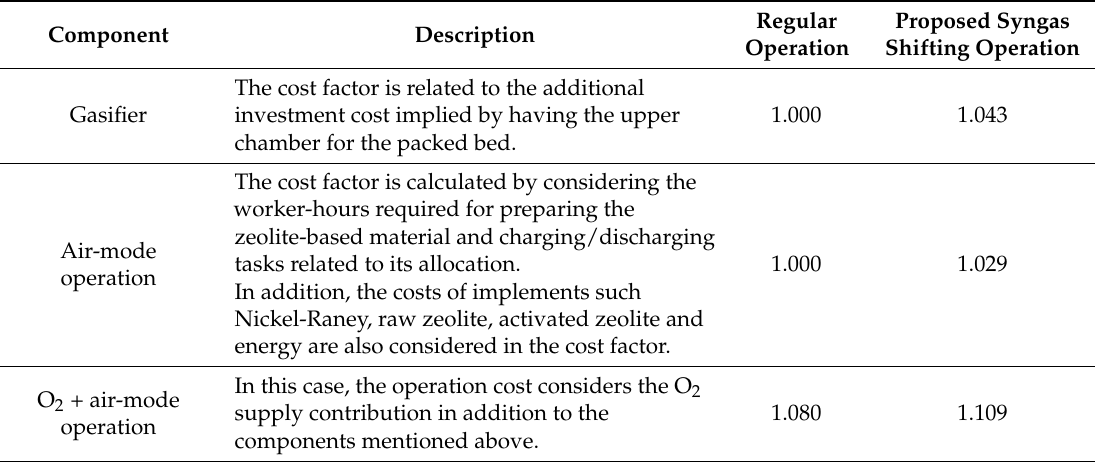
Table 10. Relative cost factors of gasifiers with packed-bed chamber